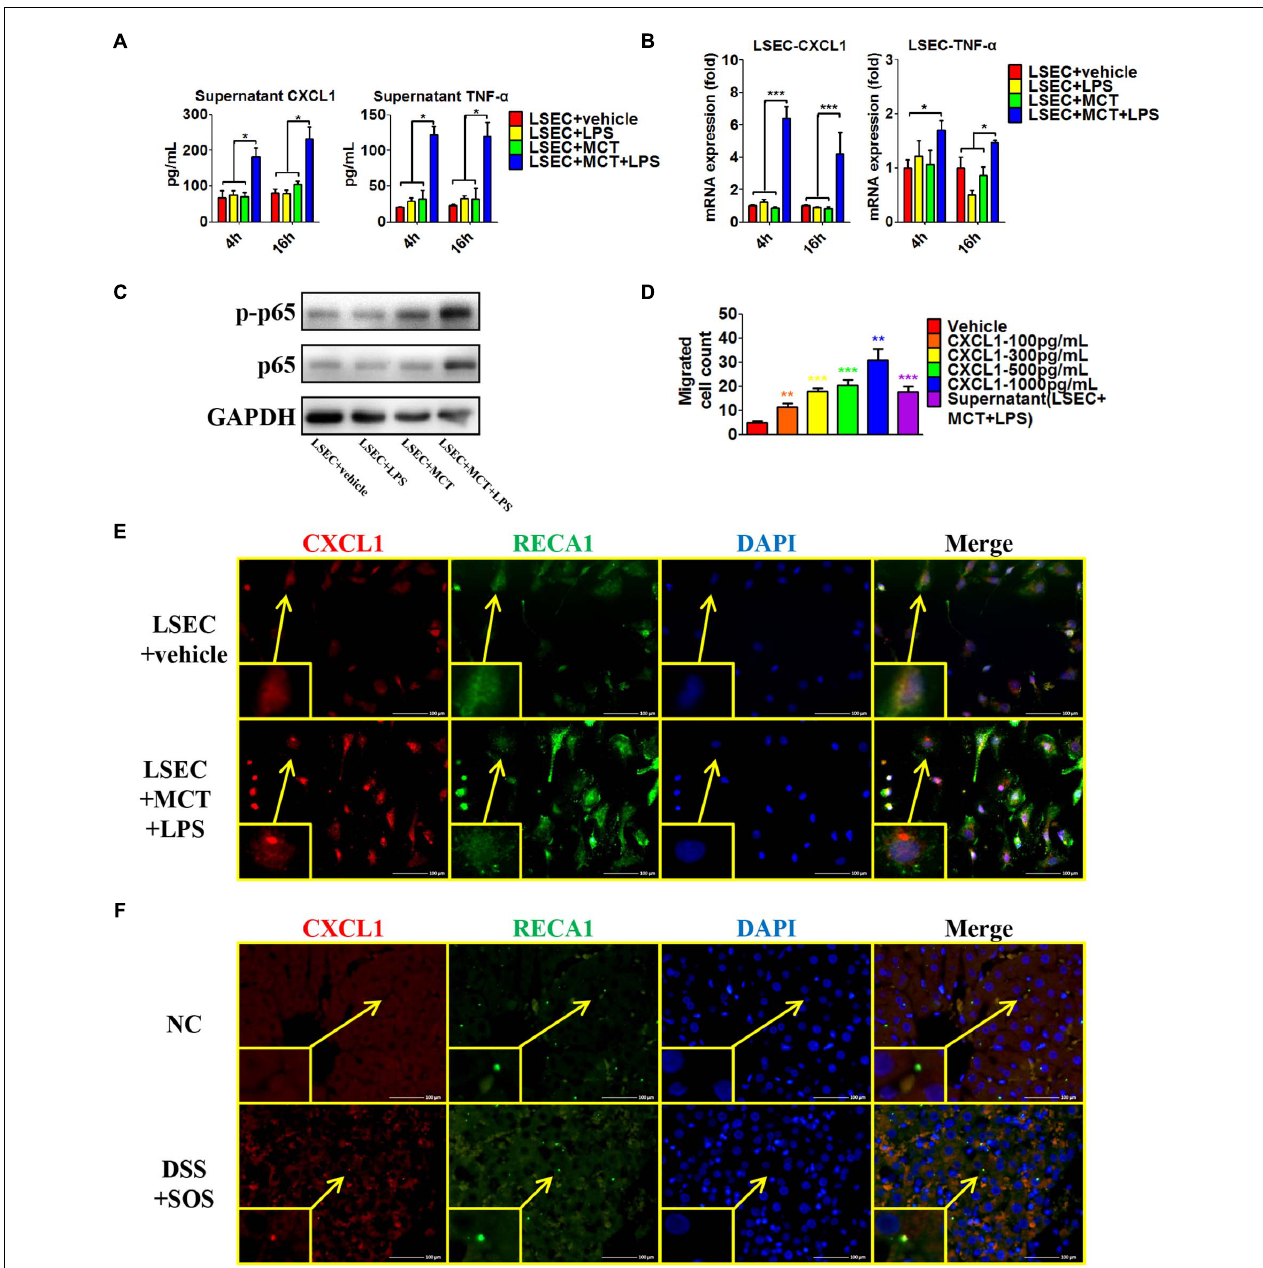
FIGURE 6 | Pro-inflammatory phenotype of damaged LSECs. After LSECs were treated with different stimuli [vehicle, lipopolysaccharide (LPS), monocrotaline (MCT), and MCT + LPS], the following parameters were examined: (A) the supernatant CXCL1 and TNF- α , tested by ELISA; (B) mRNA levels of CXCL1 and TNF- α ; (C) phosphorylation of LSEC p65. (D) The influence of CXCL1 on neutrophil chemotaxis was evaluated by the number of trans-membrane migrated neutrophils in the Transwell experiment. (E) LSEC-derived CXCL1 was also examined by immunocytochemistry of CXCL1 (red) and RECA-1 (green, a marker of rat endothelial cells). (F) The co-localization of CXCL1 (red) and RECA-1 (green) was detected by immunohistochemistry in colitis-induced liver injury. Asterisk indicates that the level is significantly different from normal control. * p < 0.05; ** p < 0.01; *** p < 0.001 by one-way ANOVA; n = 6 in each group; panels (A–C) are representative of three experiments; panel (C) is representative of one experiment, while other panels are representative of three experiments.